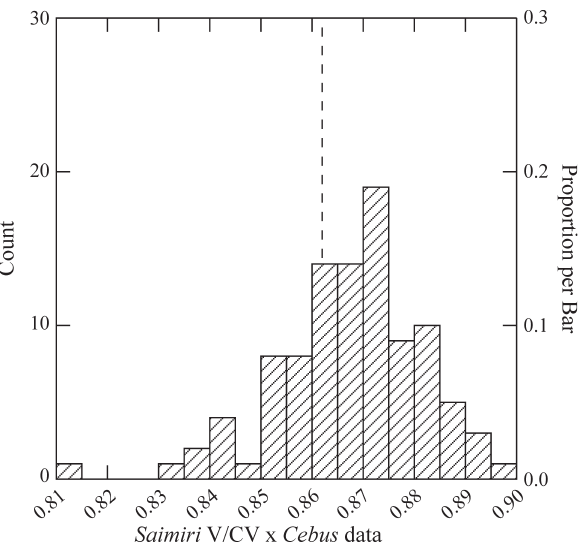
Figure 3 - Example of distribution properties of the RS correlation. In this case the Saimiri covariance matrix is compared to a series of matrices gen- erated via Monte Carlo from a covariance matrix based on the Cebus covariance